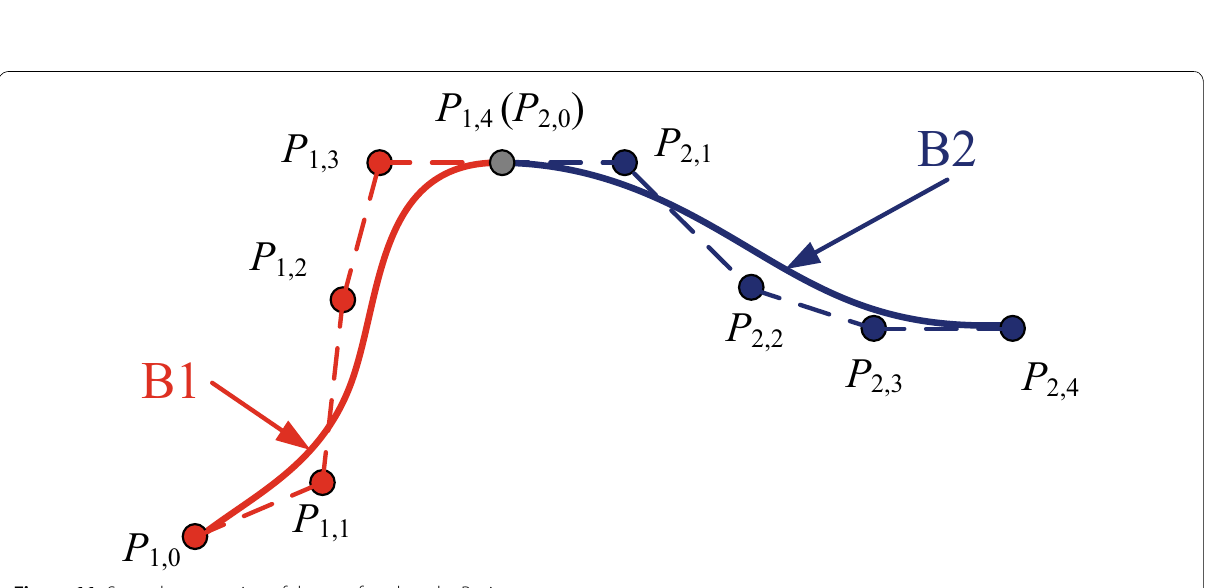
Figure 11 Smooth connection of the two fourth-order Bezier